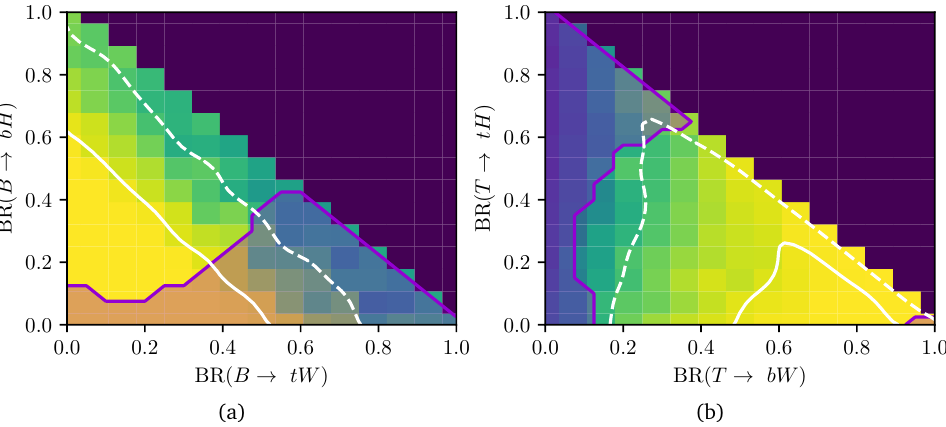
= 1200GeV Figure 5: Sensitivity of LHC measurements to (a) B -production for M B = 1350GeV. The C ONTUR exclusion is shown in the and (b) T -production for M T bins in which it is evaluated, graduated from yellow through green to black on a linear scale, with the 95% CL (solid white) and 68% CL (dashed white) exclusion contours superimposed. The mauve region is excluded at 95% CL by the ATLAS combination [ 20 ]